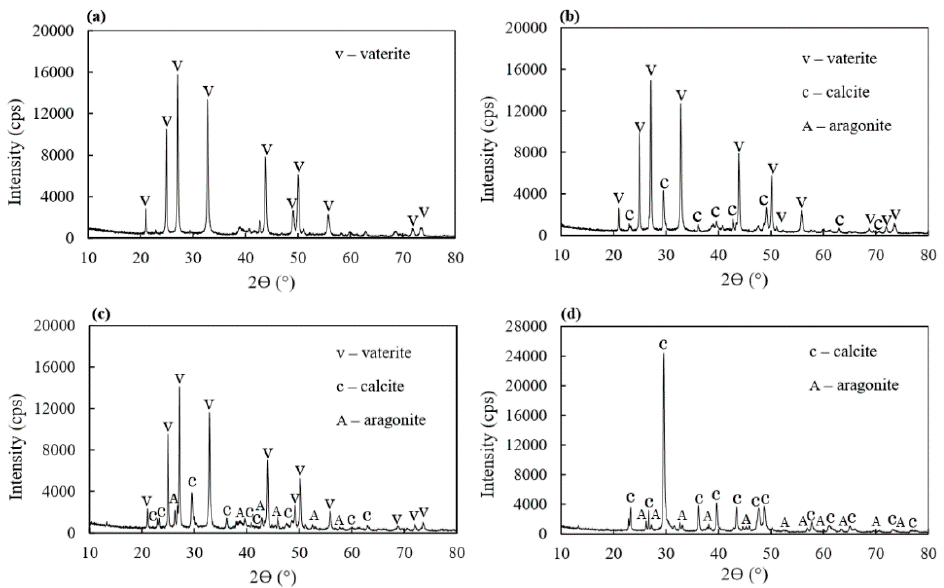
Figure 12. X-ray diffraction ( XRD) spectra of the microbial induced precipitate by Sporosarcina sp. with ( a ) Mg 2+ /Ca 2+ = 0.00; ( b ) Mg 2+ /Ca 2+ = 0.25; ( c ) Mg 2+ /Ca 2+ = 0.43; ( d ) Mg 2+ /Ca 2+ = 1.00.